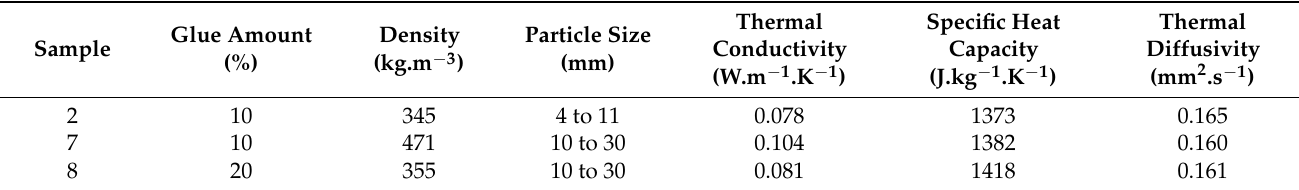
Table 3. Measured average values of input and output parameters for the boards with particles oriented perpendicular to the panel ´ s plane.